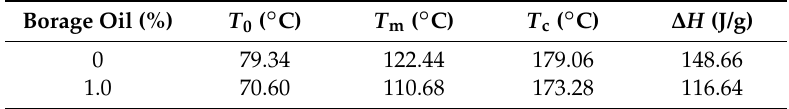
Table 4. Thermal properties of the BMS films containing BO. T 0 : onset temperature, T m : melting temperature at peak, and T c : conclusion temperature, Δ H : fusion enthalpy.